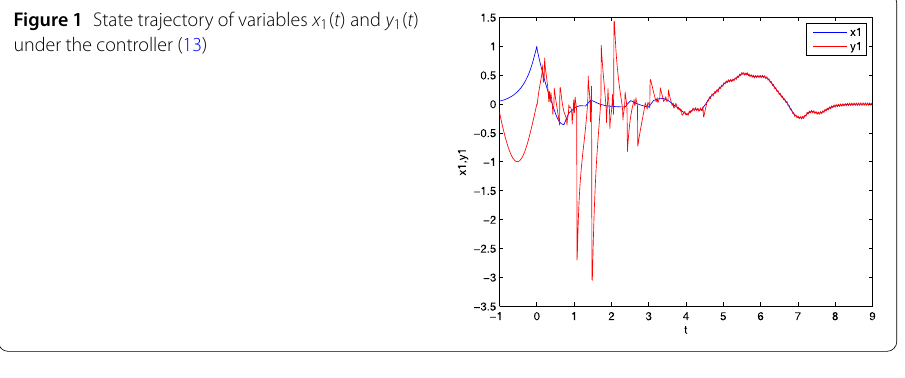
Figure 2 State trajectory of variables x 2 ( t ) and y 2 ( t ) under the controller